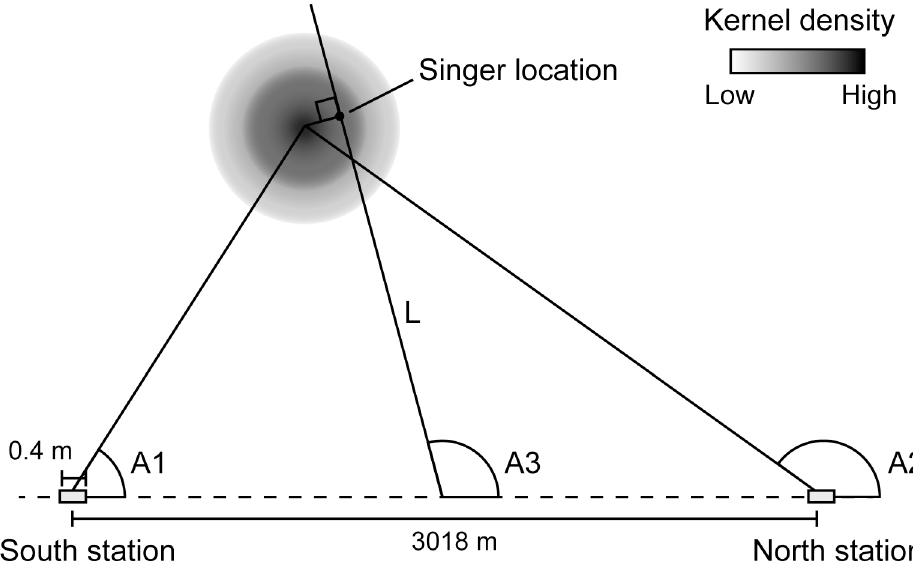
Fig 2. Calculation of singer’s location. Using two bearing angles from two recorders A1 and A2, the location of each unit could be calculated by triangulations. The bearing angle measured by the time shift of unit contour between two recorders (A3) is more accurate. The location of the singer was estimated as the cross point at the perpendicular line from the highest kernel density to the third bearing angle line (L).